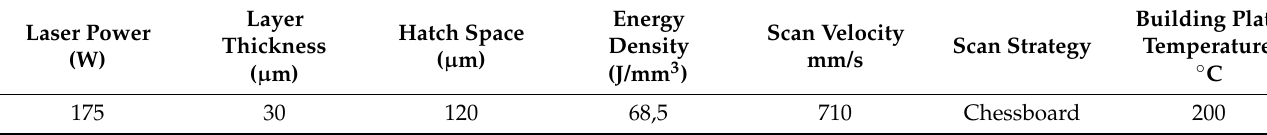
Table 2. The SLM 250HL process